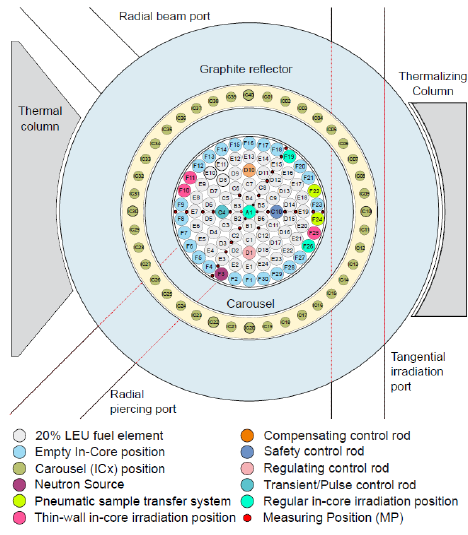
Fig. 1. Core configuration during the measurement